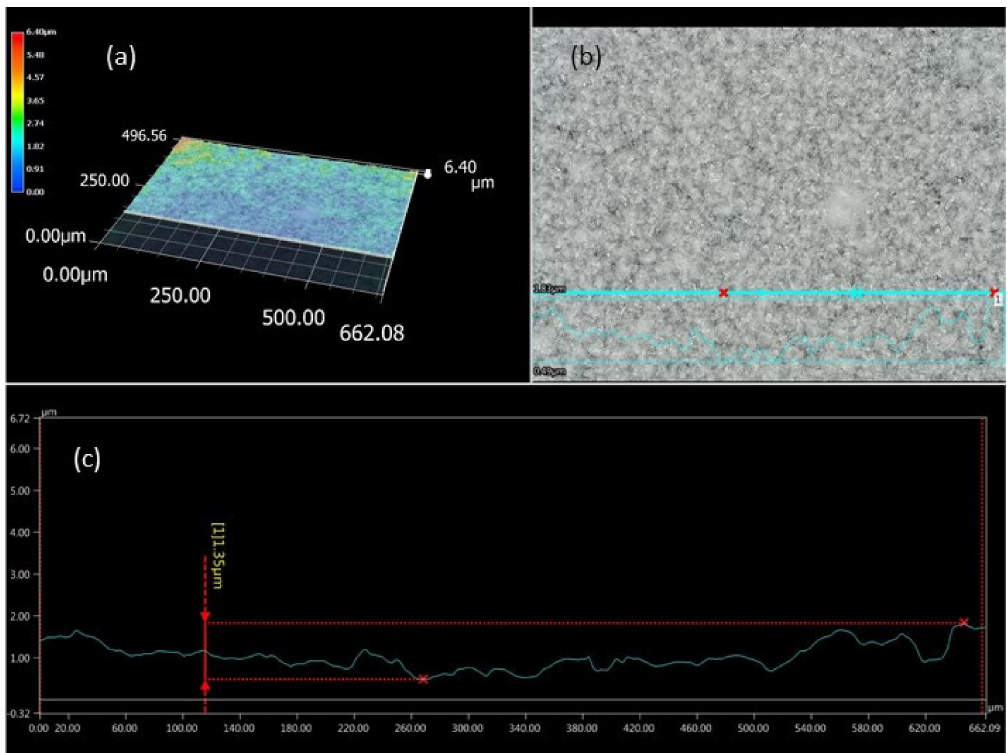
Figure 4. Digital microscope images ( a and b ) and 3D surface topography ( c ) of the upper surface of the HPMC ODF (LO 30% w / w